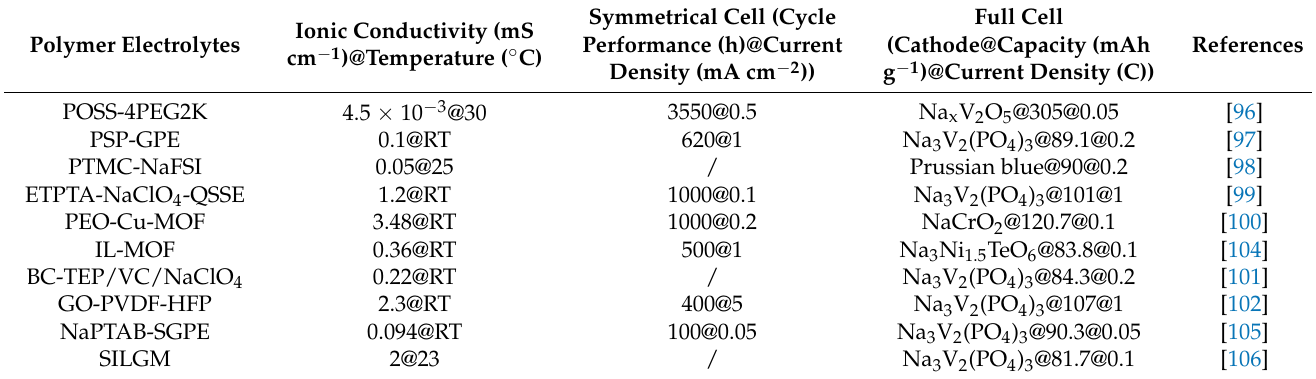
Table 2. Electrochemical properties of different polymer electrolytes in NMBs.